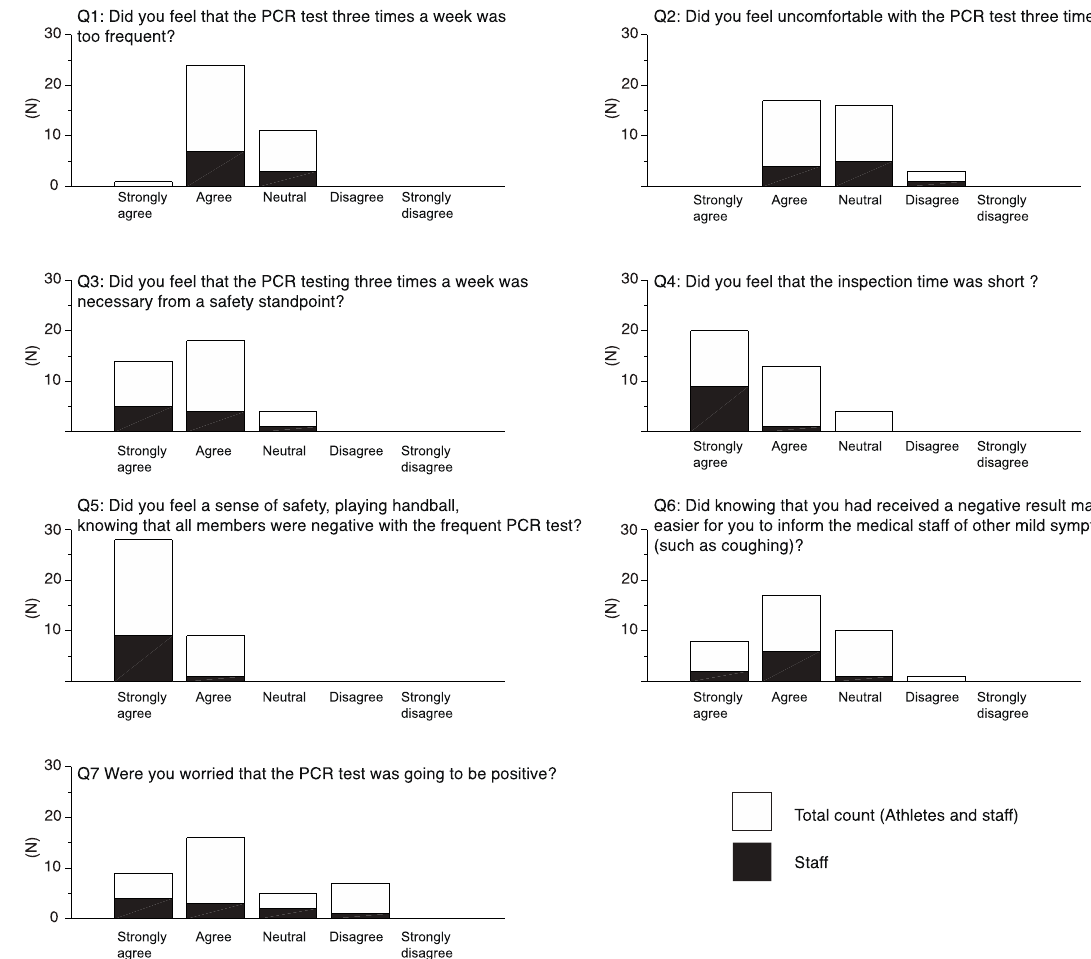
Figure 3. Results of online questionnaire regarding perception of PCR tests during the camp.